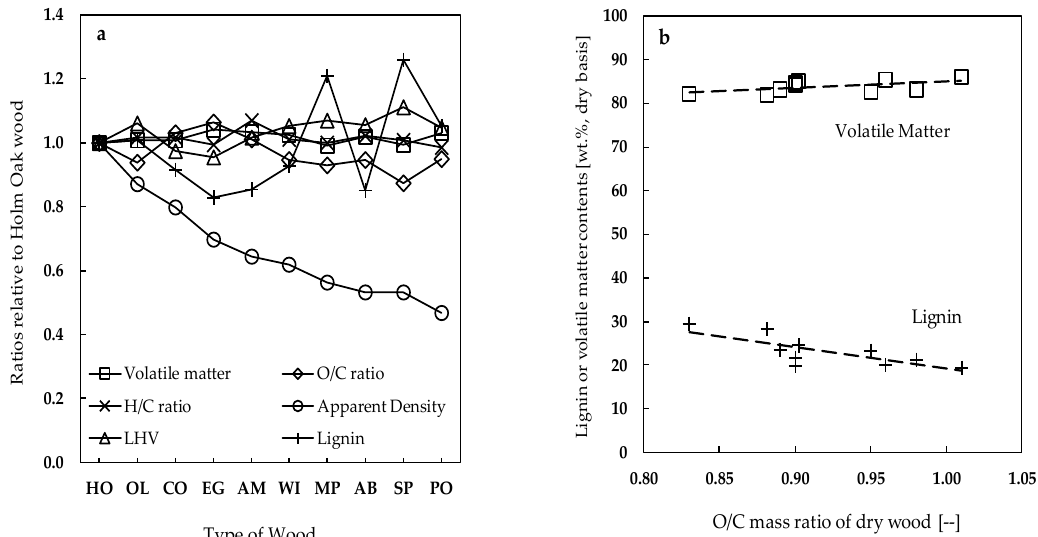
Figure 2. Ratios of selected physicochemical properties of distinct wood types in relation to those of holm oak wood ( a ), and lignin or volatile matter contents of wood as a function of the respective O/C mass ratios ( b ). HO — holm oak, OL — olive tree, AM — acacia mimosa, EG — eucalyptus globulus, CO — cork oak, WI — gray willow, AB — Australian blackwood, SP — stone pine, MP — maritime pine, PO — poplar.